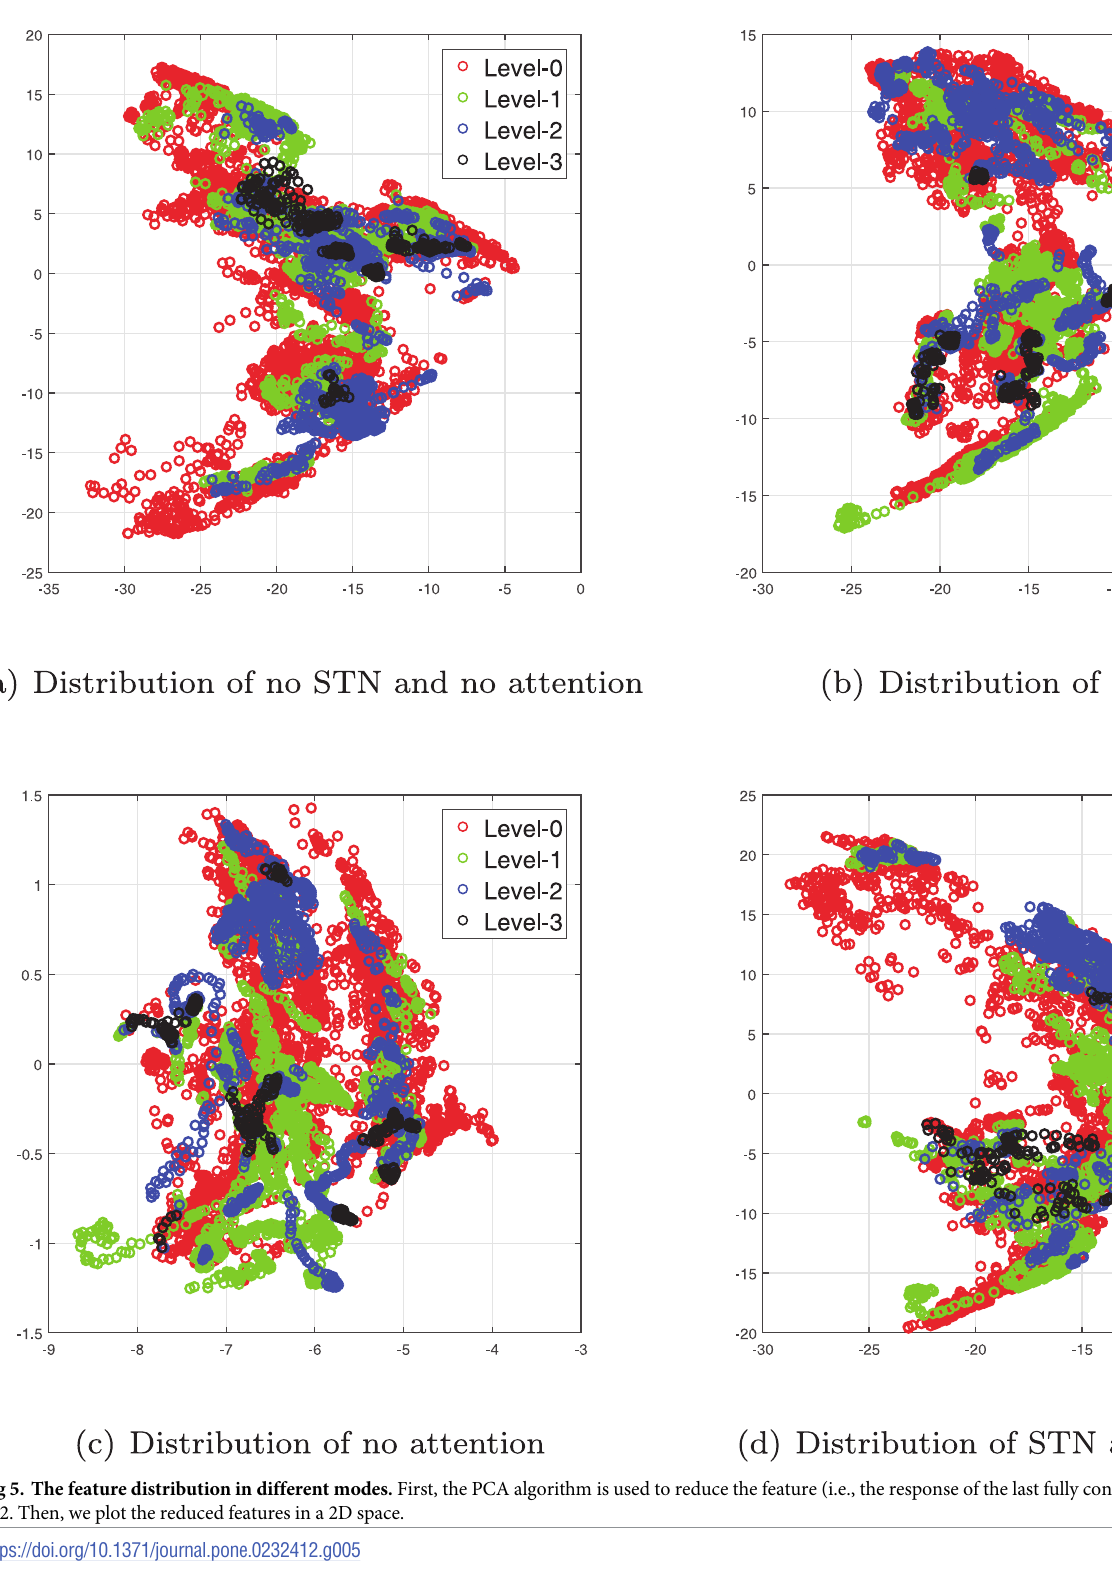
PLOS ONE | https://doi.org/10.1371/journal.pone.0232412 August 21,